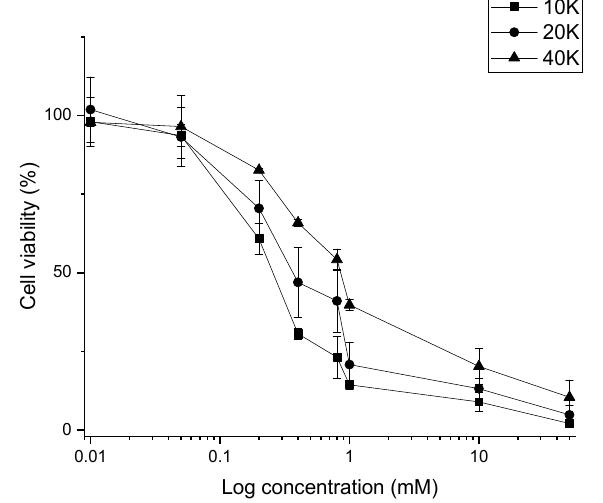
Figure 7. Cell viability assay for determination of EC50 of Hydroxyurea at three different cell con ‐ centrations (1 × 10 4 , 2 × 10 4 , and 4 × 10 4 cells/well). (Mean ± SD, n =